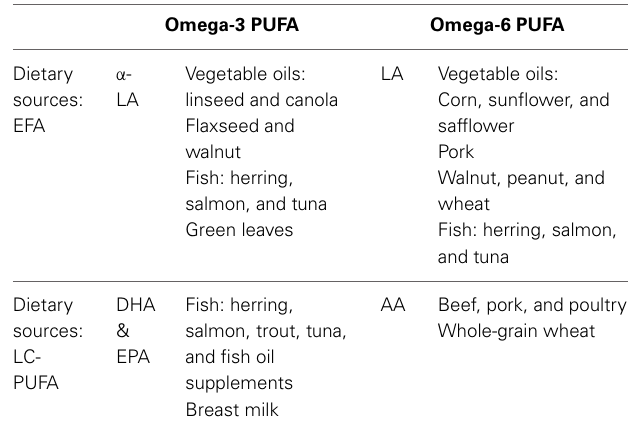
Table 1 | Common dietary sources of n -3 and n -6: short chain essential fatty acids ( α -LA and LA) and long chain